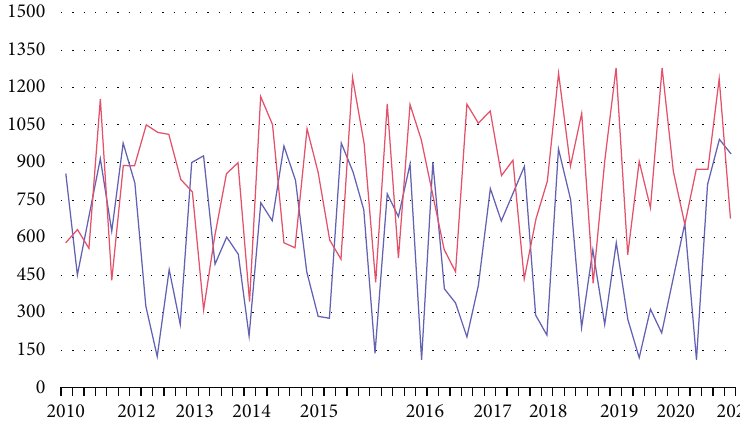
Figure 5: The total number of netizens in previous surveys.